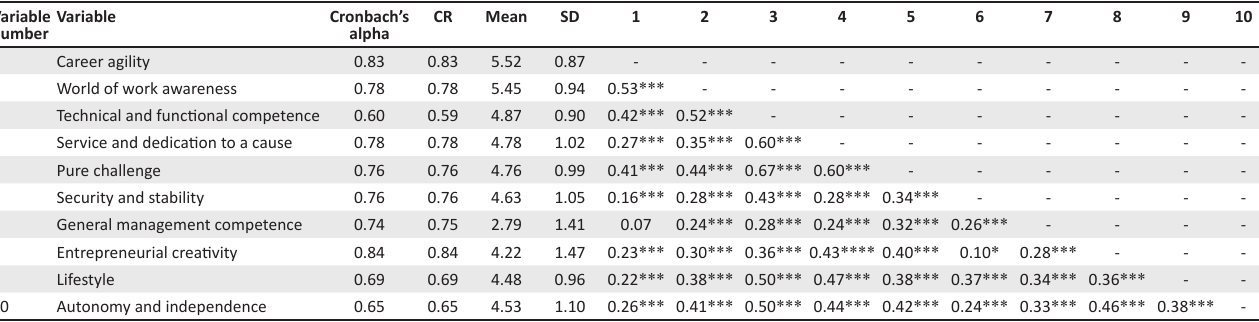
TABLE 1: Descriptive statistics, reliability estimates and bivariate correlations ( n = 486). Variable Variable number